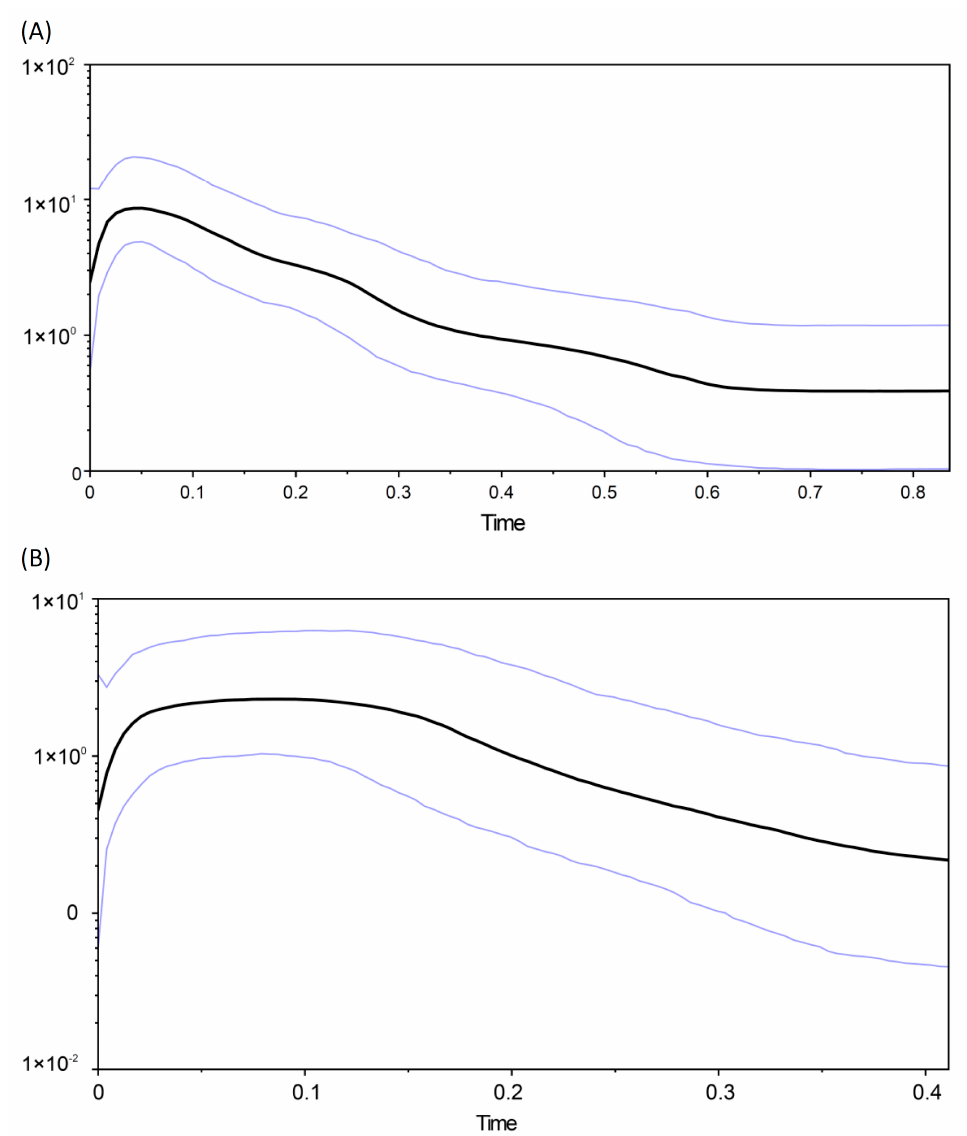
Figure 5. Bayesian skyline plot of effective population sizes over time for ( A ) A. fasciatus and ( B ) A. wenchowensis . The X -axis is the time scale in millions of years, and the Y -axis is the estimated effective population size in units of Nes, the product of effective population size and generation length in years (log transformed). The solid line indicates the median estimate, whereas the thinner lines indicate the 95% credibility intervals.